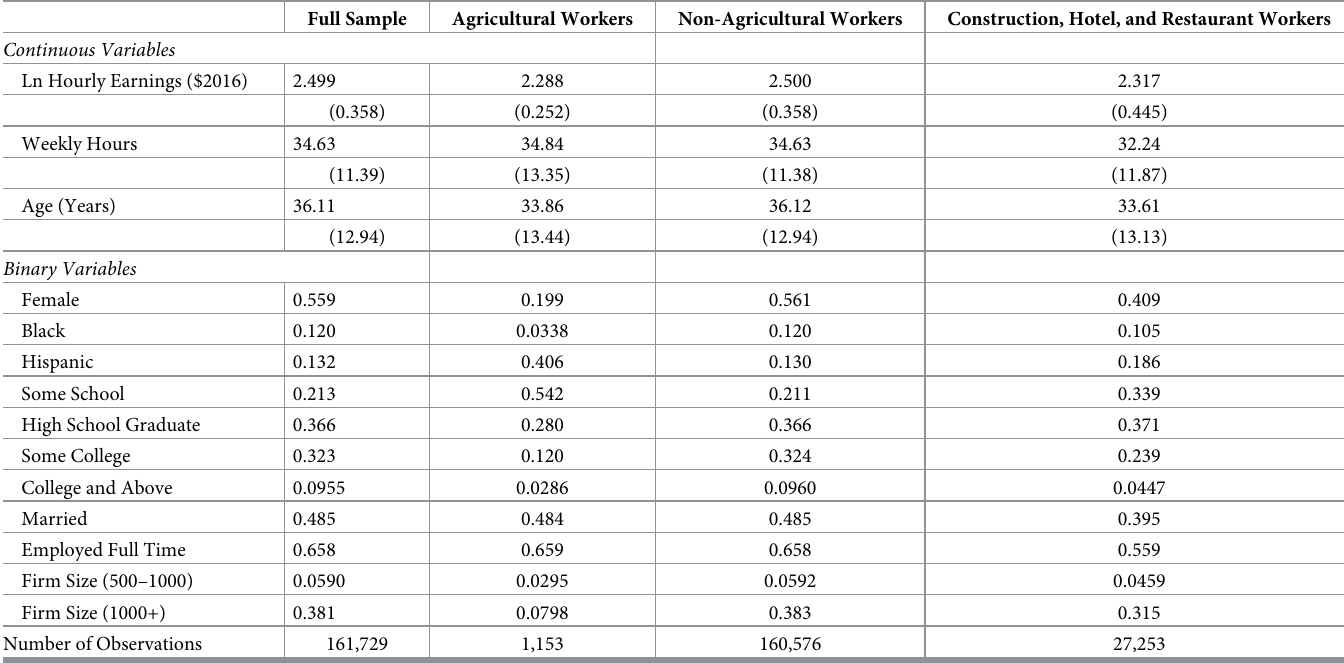
Table 1. Summary statistics (current population